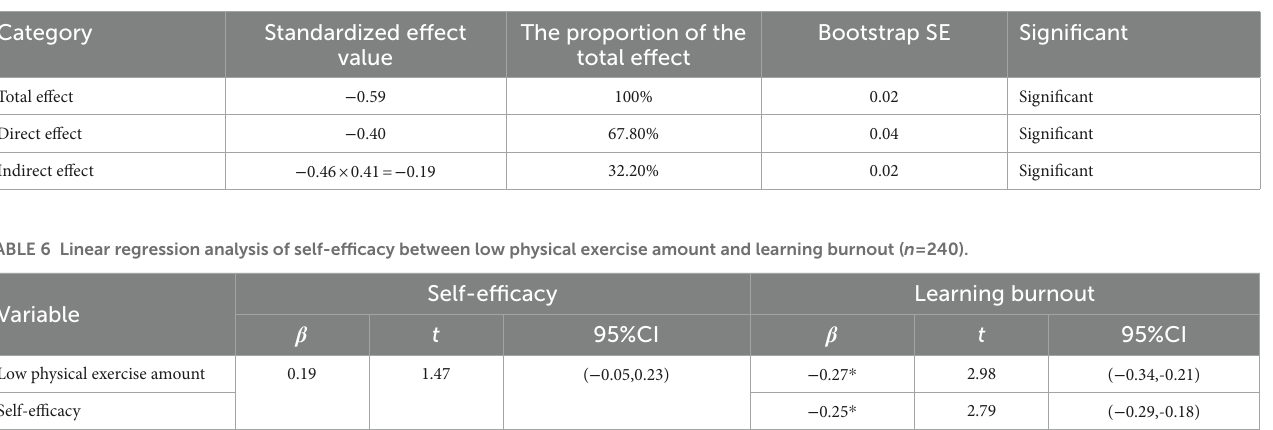
TABLE 7 Linear regression analysis of self-efficacy between moderate physical exercise amount and learning burnout ( n = 218).